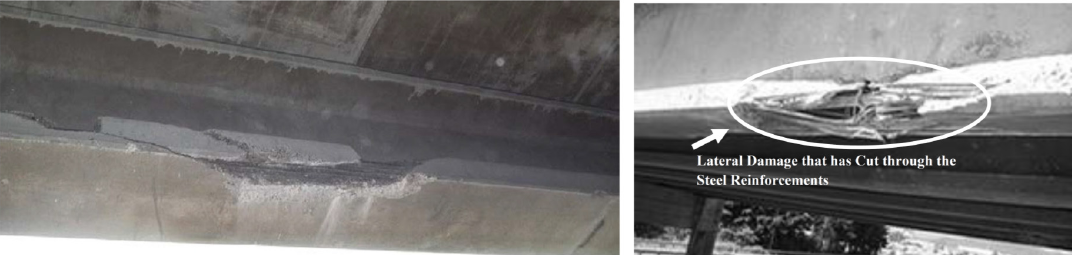
Figure 19. Severe concrete spalling due to overheight truck impact damage [6], and example of lateral impact damage on steel reinforcement [24].